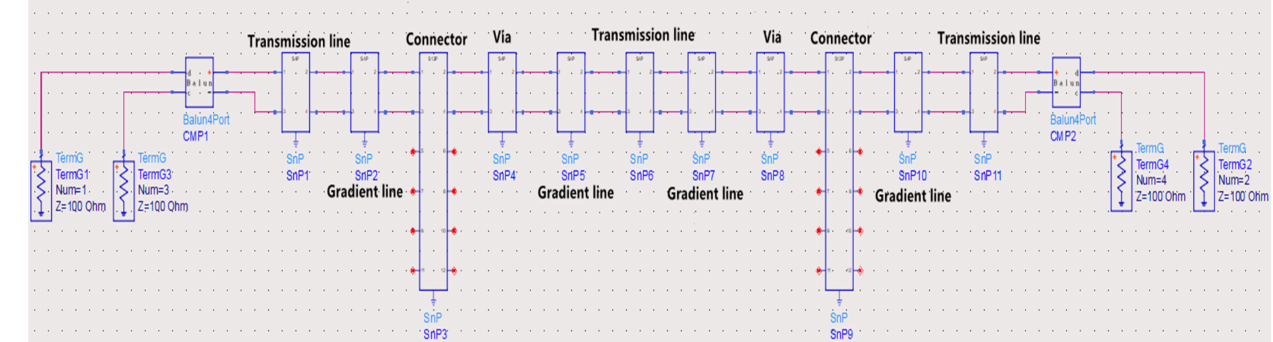
Figure 9. Modeling diagram of backplane full link S-parameter model.